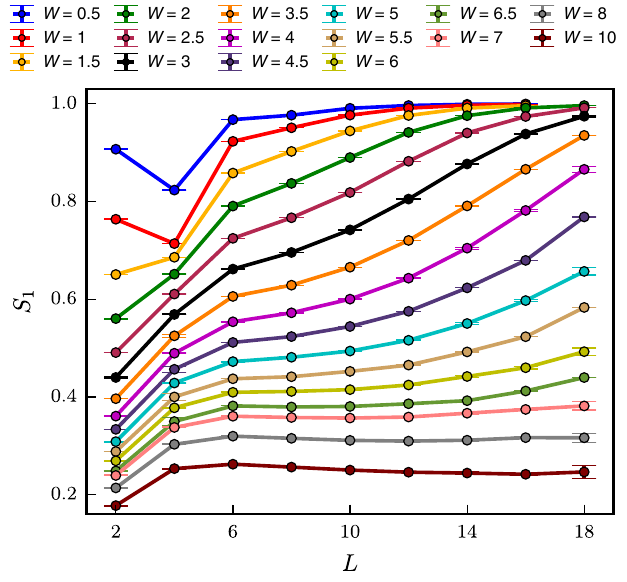
FIG. 3. Disorder- and eigenstate-averaged entanglement en- tropy S 1 (in bits) computed in eigenstates of the full system, for a subsystem comprising one spin at the end of the chain. The (rounded) “ plateaus ” in S 1 for intermediate L and W are associated with the quantum critical regime, and they show strongly subthermal values of S 1 .